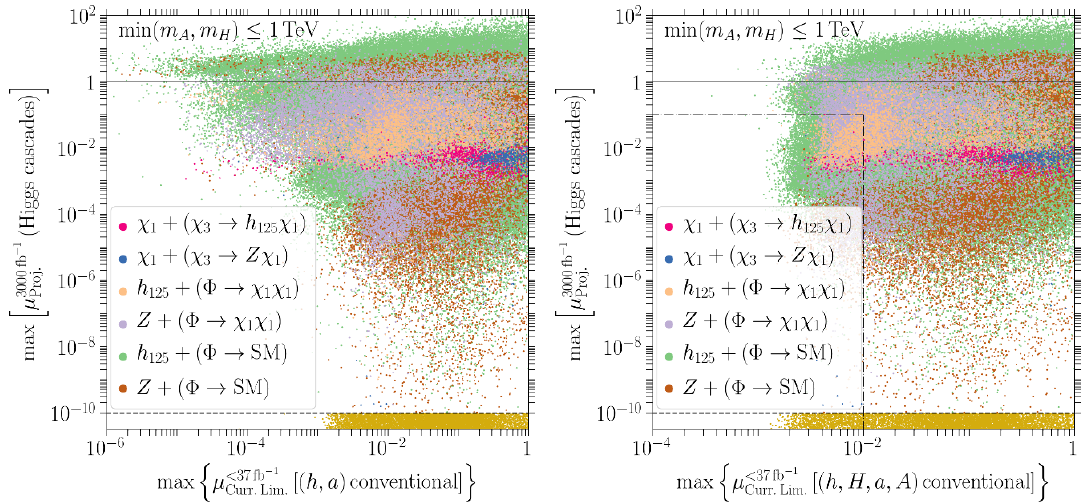
Figure 8 . Left: same as (cid:12)gure 7 but that the x -axis shows the largest signal strength of all conventional Higgs searches listed in table 2 arising through the production of the light states h and a , and the y -axis shows the largest signal strength of all the Higgs cascade searches. Note that for the Higgs cascades modes we use the projected sensitivity for L = 3000 fb (cid:0) 1 of data while for the conventional searches we use the best current limit. We cut o(cid:11) the x -axis at (cid:22) < 37fb (cid:0) 1 since points to the right of that are already excluded. Right: same as the left panel, but the x -axis shows the best signal strength of the conventional channels including those arising via the direct production of the heavy non SM-like CP-even and CP-odd states H and A . In section 4, we entertain the scenario that the LHC collaborations will be able to improve their sensitivities by one order of magnitude for the Higgs cascade decays compared to our projections (i.e. to (cid:22) 3000fb (cid:0) 1 axis) and two orders of magnitude compared to current conventional limits (i.e. to (cid:22) < 37fb (cid:0) 1 on the x -axis). Then, all points except those in the bottom-left quadrangle bounded by the dash- dotted lines may be probed at the LHC with 3000 fb (cid:0) 1 of data. This quadrangle encloses only (cid:25) 10 % of the points shown | thus, such an improvement would allow future runs of the LHC to cover almost all ( (cid:25) 90 %) of the phenomenologically viable NMSSM parameter space containing additional Higgs bosons with masses below 1 TeV. Note that the scales of the x -axes di(cid:11)er between the panels.